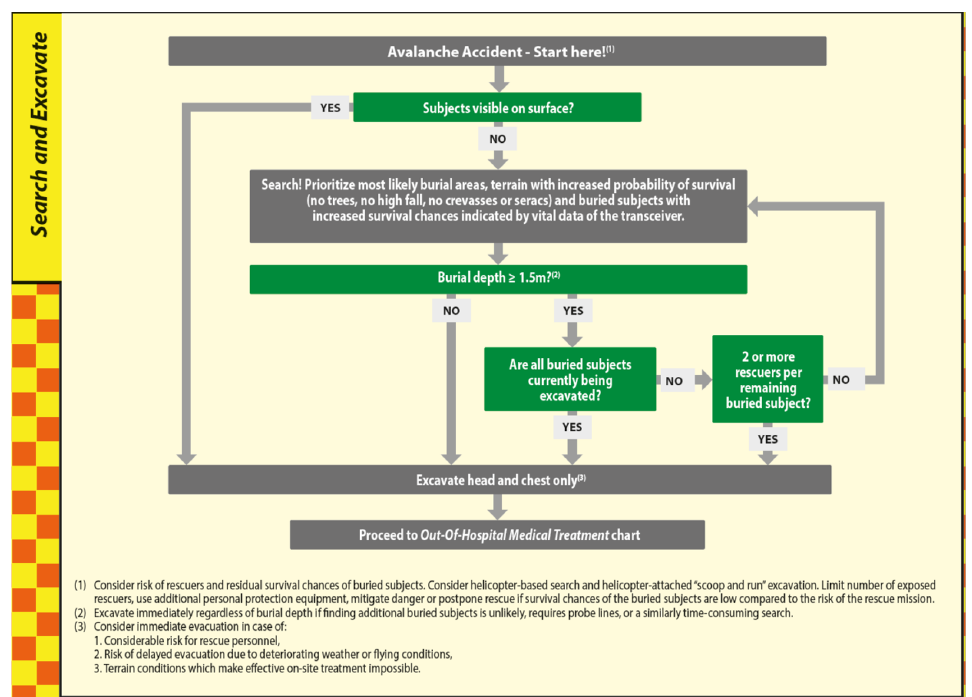
Figure 6. Optimal number of rescuers for efficient excavation applying the snow conveyor belt tech- nique [16]. Illustration: MountainSafety.info as of 31 December 2021, reprinted with permission of MountainSafety.info.